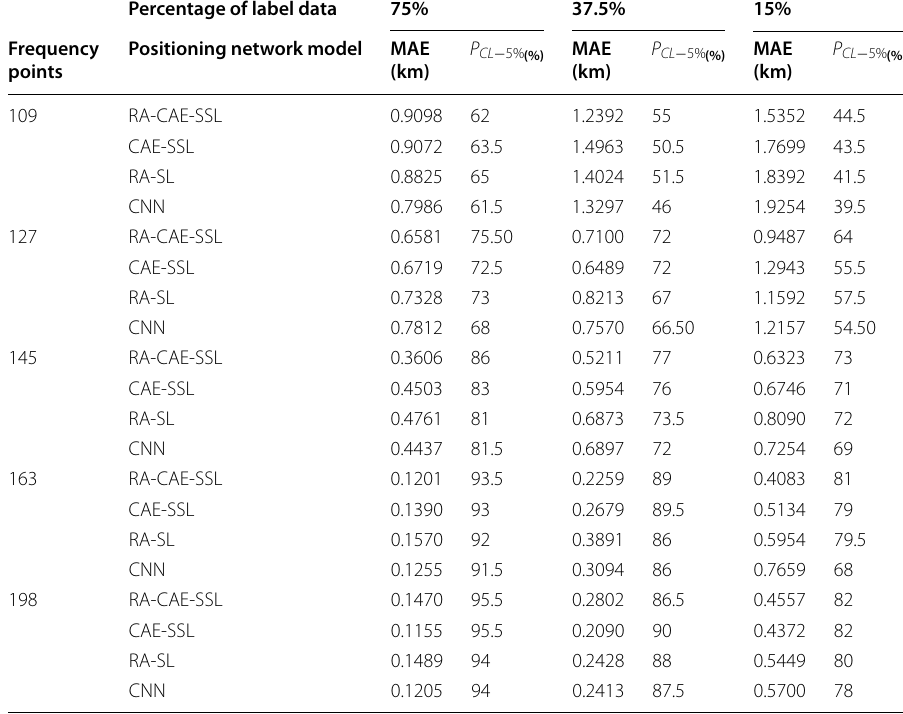
Table 2 Localization performance of narrowband dataset